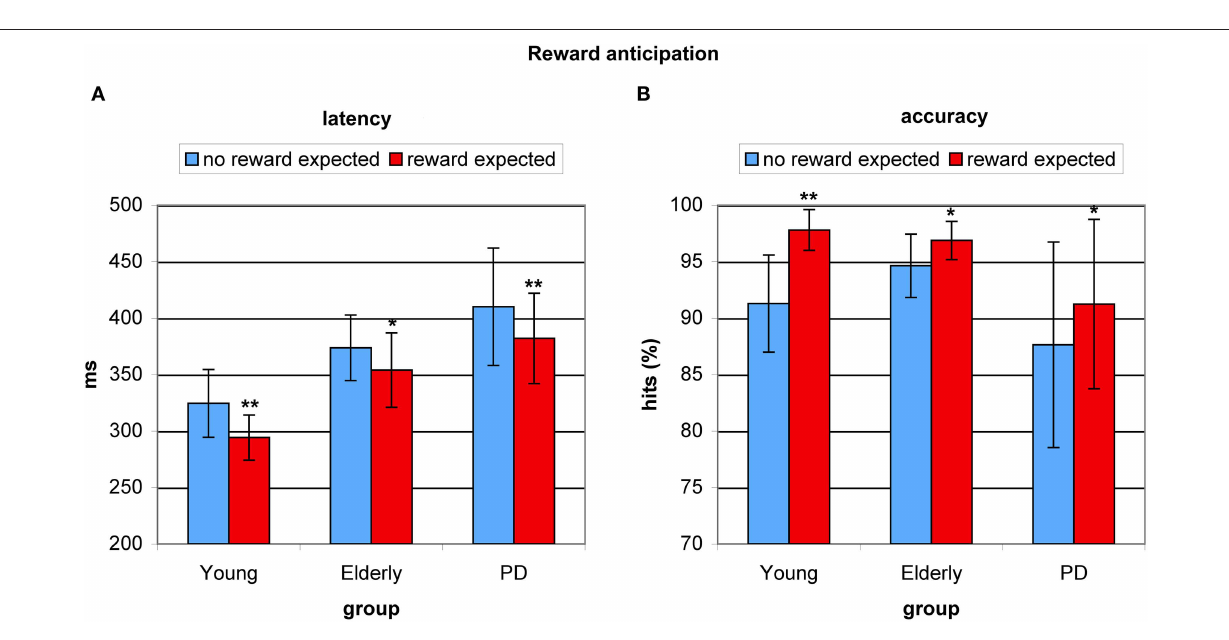
Figure 3 | Benefits from reward anticipation in young healthy participants, healthy elderly, and Parkinson’s patients (PD). (A) Average antisaccade onset latency was significantly faster on reward anticipation trials (red) than on trials where no reward was expected (blue). (B) Average antisaccade accuracy was significantly higher on reward anticipation trials (red) than when no reward was anticipated (blue). * P < 0.05; ** P < 0.01.